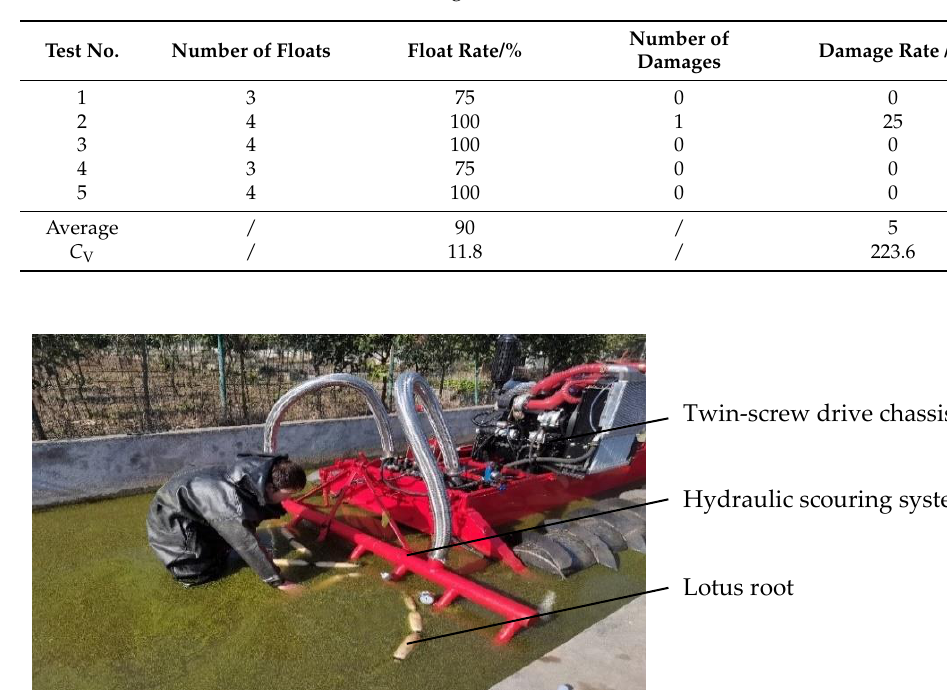
Table 12. Test results of lotus root harvesting.